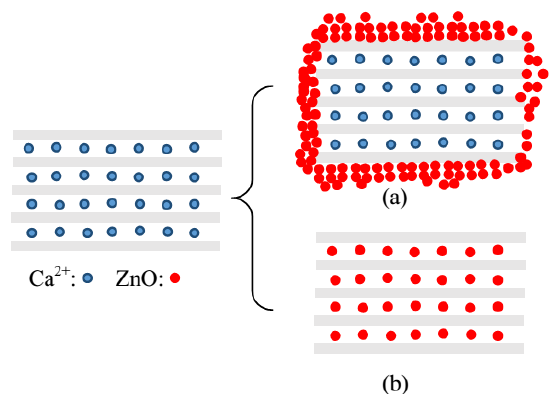
Fig. 2. The Schematic illustration of the composites prepared by using precipitation method (a) and ion exchange method (b) Table 1. Composition (% w/w) of parent bentonite and ZnO/bentonite photocatalysts